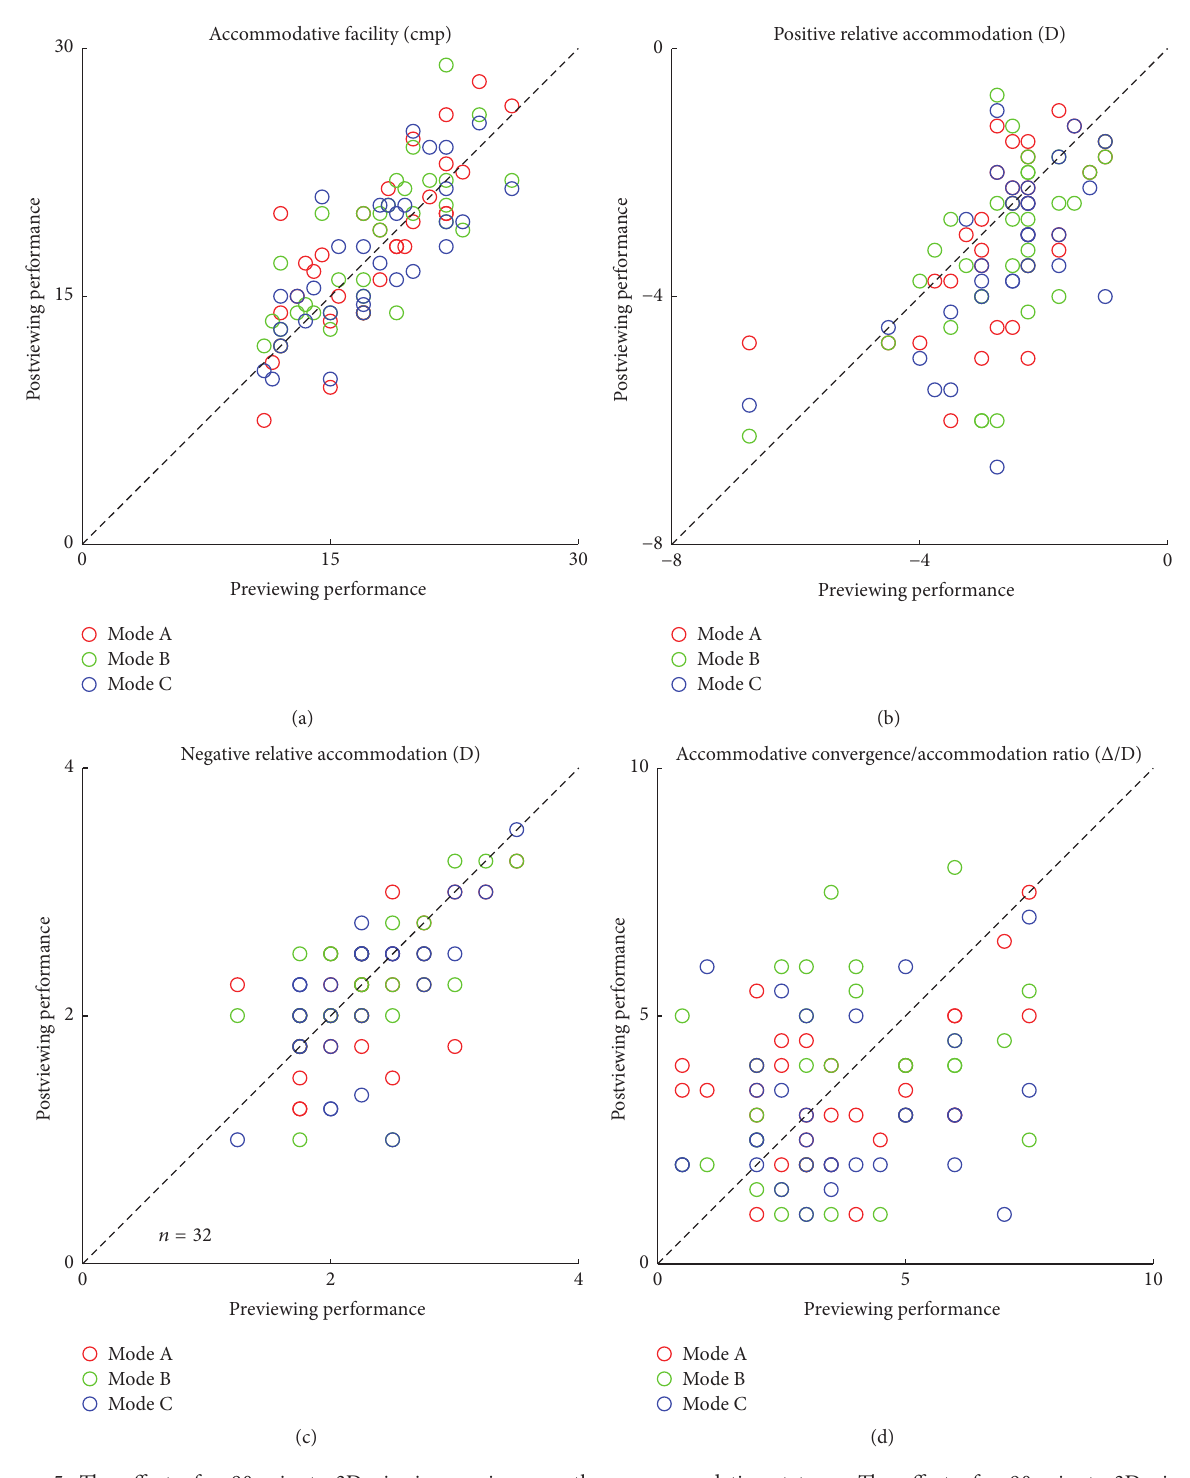
Figure 5: The effect of a 90-minute 3D viewing session on other accommodative statuses. The effect of a 90-minute 3D viewing session on accommodative facility (a), positive relative accommodation (b), negative relative accommodation (c), and the accommodative convergence/accommodation (AC/A) ratio (d). An identity line ( 𝑋 = 𝑌 ) is plotted in each